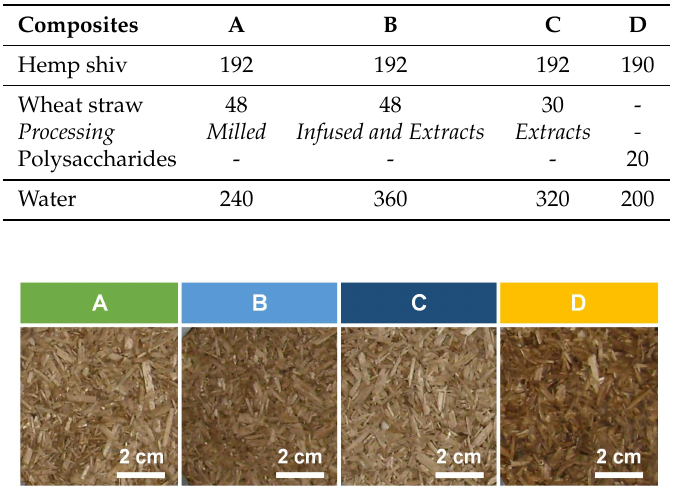
Table 1. Formulation of composites: component mass (g) and binder processing (wheat straw or polysaccharides).